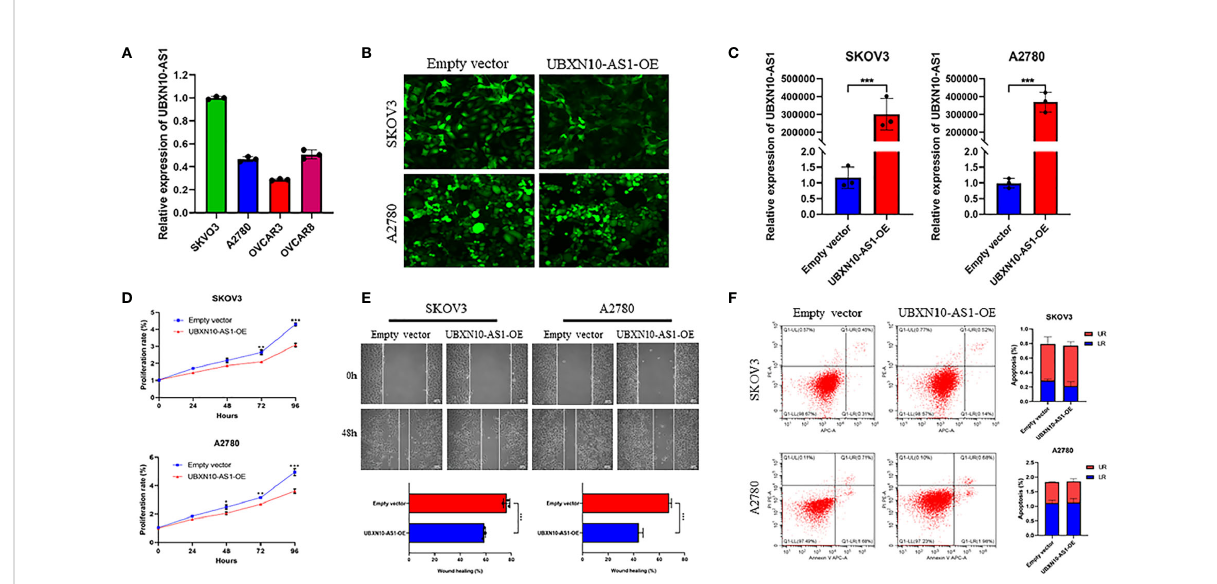
FIGURE 8 UBXN10-AS1 signi fi cantly suppressed cell proliferation and inhibited cell migration in SKOV3 and A2780 cell lines. Expression of UBXN10-AS1 in SKOV3, A2780, OVCAR3 and OVCAR8 cell lines (A) ; Overexpression of UBXN10-AS1 in SKOV3 and A2780 cell lines (B, C) ; Overexpression of UBXN10-AS1 signi fi cantly suppressed cell proliferation in SKOV3 and A2780 cell lines (D) ; Overexpression of UBXN10-AS1 signi fi cantly inhibited cell migration in SKOV3 and A2780 cell lines (E) ; Overexpression of UBXN10-AS1 had no in fl uence on apoptosis in SKOV3 and A2780 cell lines (F) . *p<0.05; **p<0.01;